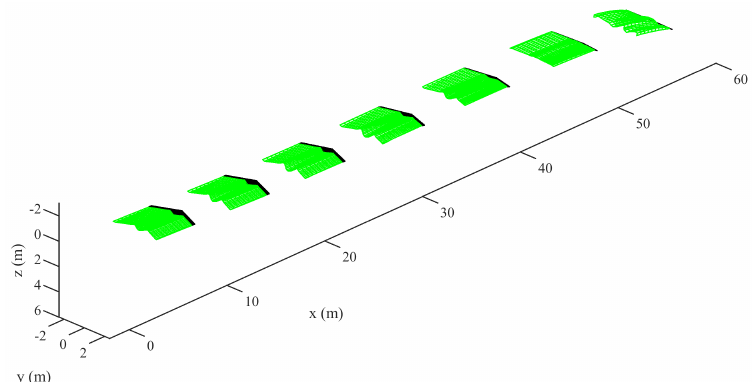
Figure 16. The glide path of a flying